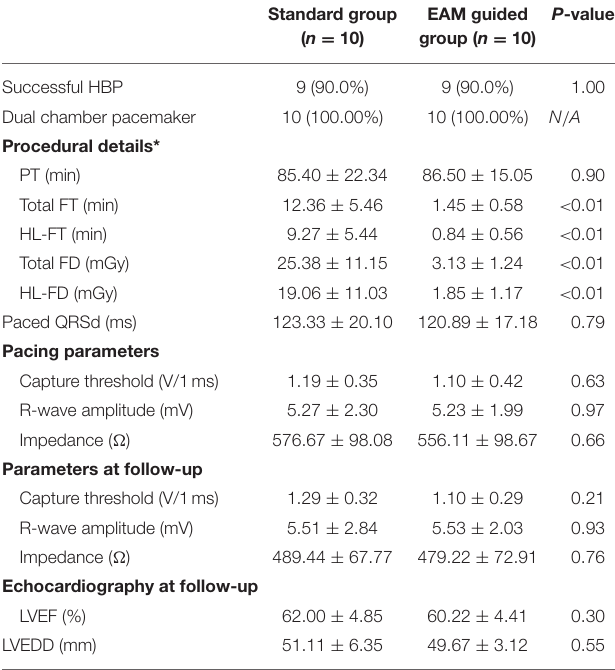
TABLE 3 | Implantation and follow-up results.